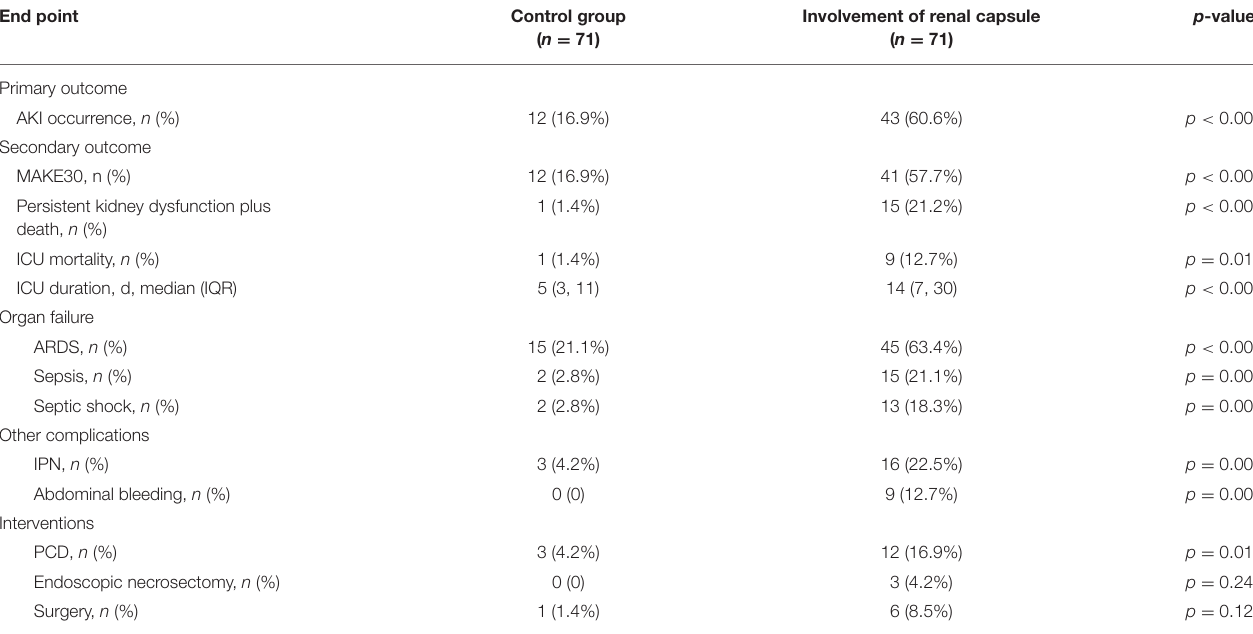
TABLE 2 | Differences in primary and secondary outcomes between the two AP